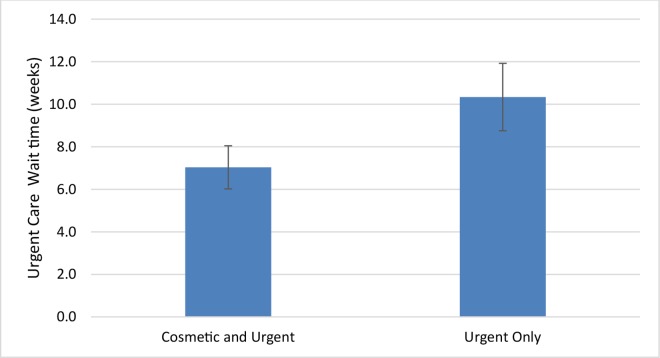
Urgent Care wait times for dermatology practices offering Cosmetic and Urgent care vs. those offering only Urgent care.Errors bars reflect Standard Error of the Mean (sem).